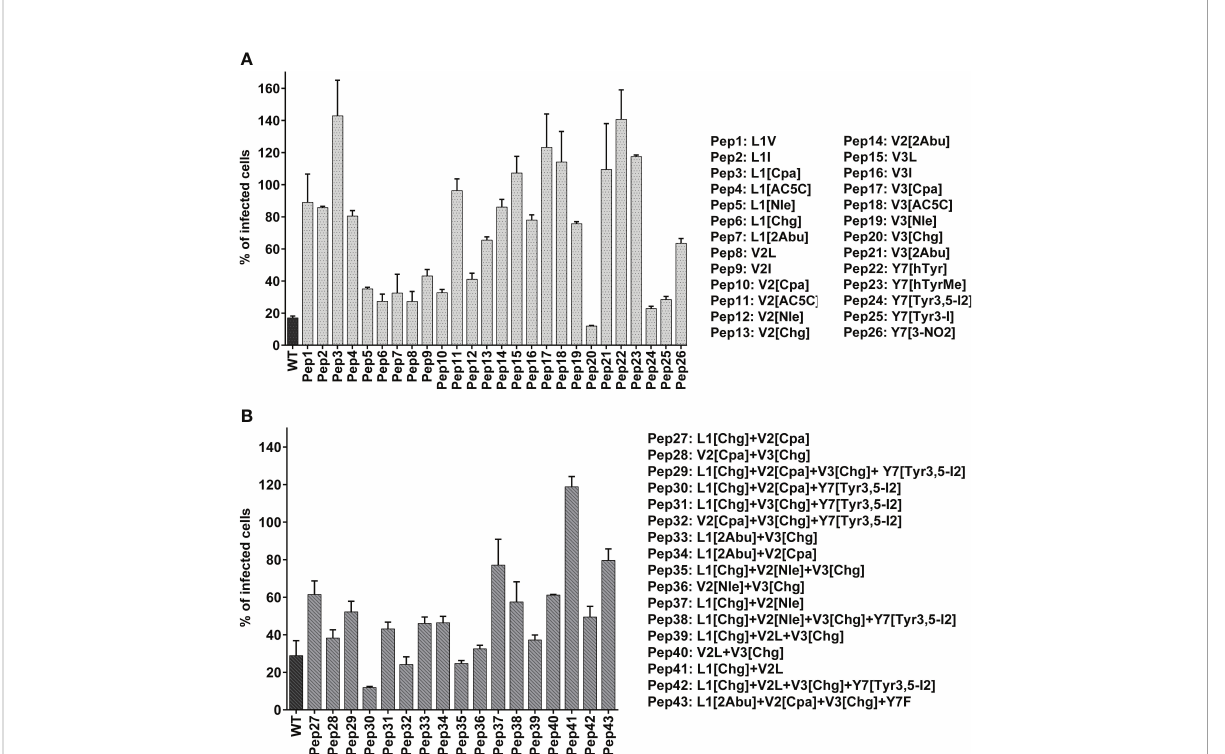
FIGURE 3 Antiviral activity of peptides modi fi ed with non-canonical amino acids. Amino acids at four functionally essential positions of the native (unmodi fi ed) peptide referred to as wildtype “ WT ” with a sequence of Ac-LVVSTTYLPHYFDN-NH 2 were substituted with their non-canonical amino acid analogs. The amino acid replacement was done either at one position (A) or multiple positions (B) using different combination of non-canonical amino acids. The screening of antiviral activity was performed by mixing the peptides either at 20 µM (A) of 10 µM (B) with 150 FFU of rgRSV and applying the mixture to HEp-2 cell monolayers. Infected cells were analyzed at 2 dpi using fl uorescence EliSpot reader and presented as % of FFU numbers in treated/sham-treated samples. Shown are mean values of two independent experiments, each in triplicates ±